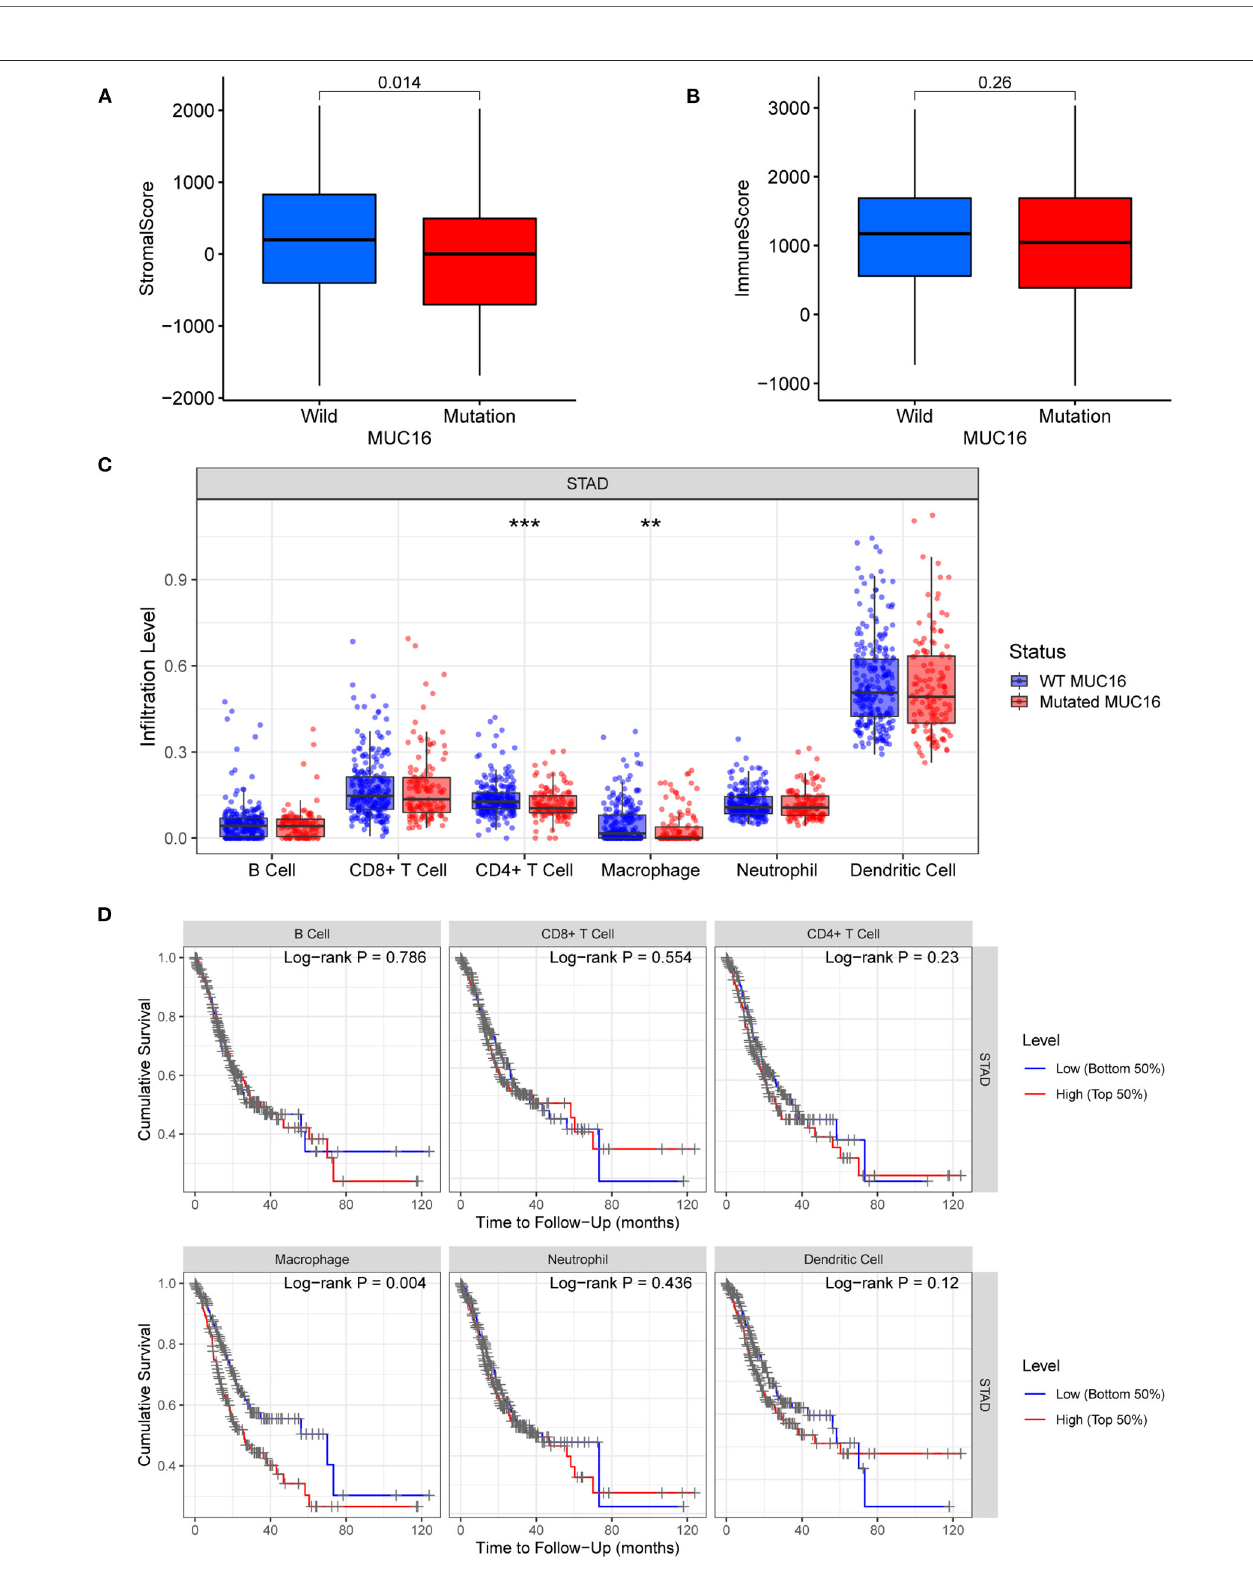
FIGURE 6 | Tumor microenvironment and immune infiltrate signatures of patients with MUC16 mutation in TCGA-STAD cohort. (A) Relationships between MUC16 mutation status and stromal scores. (B) Relationships between MUC16 mutation status and immune scores. (C) Immune infiltrate signatures stratified by MUC16 mutation status. * p < 0.05; ** p < 0.01; *** p < 0.001. (D) Association between tumor-infiltrating immune cells and survival.